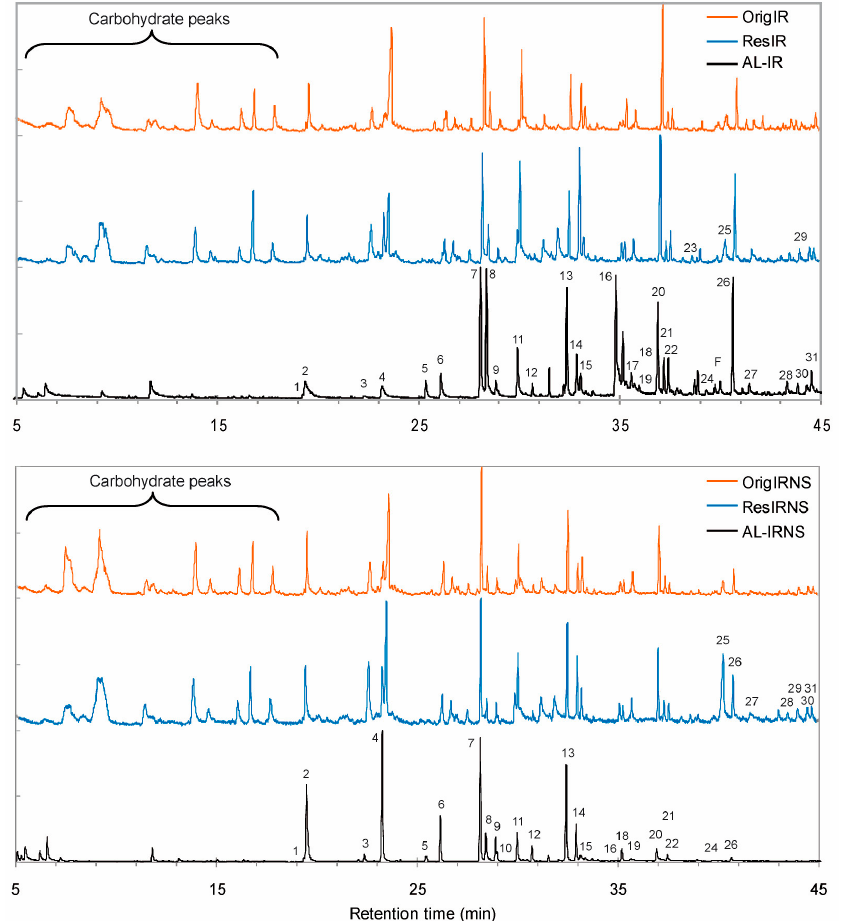
Figure 2. Pyrograms of Acidolysis lignin from Iroko and Iroko-Norway spruce sawdust (AL-IR, AL-IRNS), the respective initial sawdust samples (OrigIR, OrigIRNS) and the respective acidolysis residues (ResIR, ResIRNS).